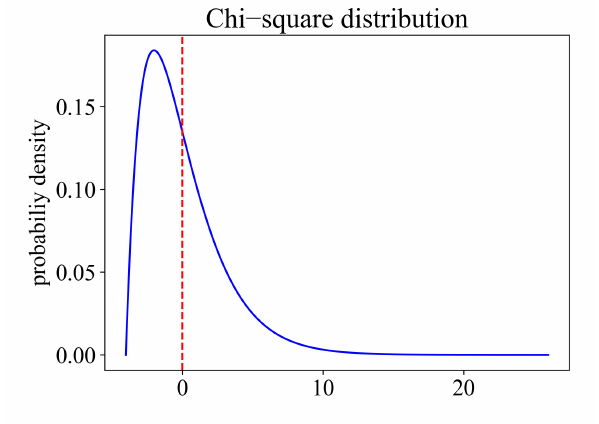
Figure 4. The probability density function of Chi square distribution δ χ 2 −